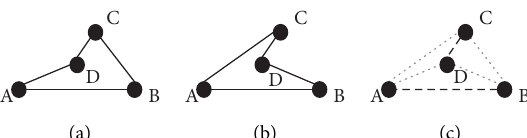
Figure 2: An example of ACO algorithm being used to find the optimal solution of TSP problem. In a population of two ants, (a) and (b) are the paths constructed by the two ants. The choice of an edge is probabilistically done. (c) shows how the pheromone levels on the edges are updated following an iteration.